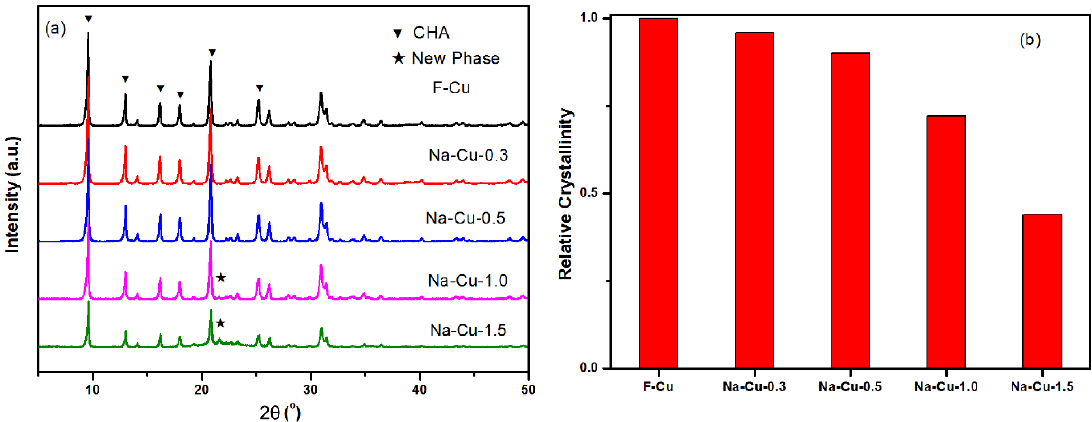
Figure 1. XRD pattern ( a ) and relative crystallinity ( b ) of fresh and Na-impregnated catalysts.